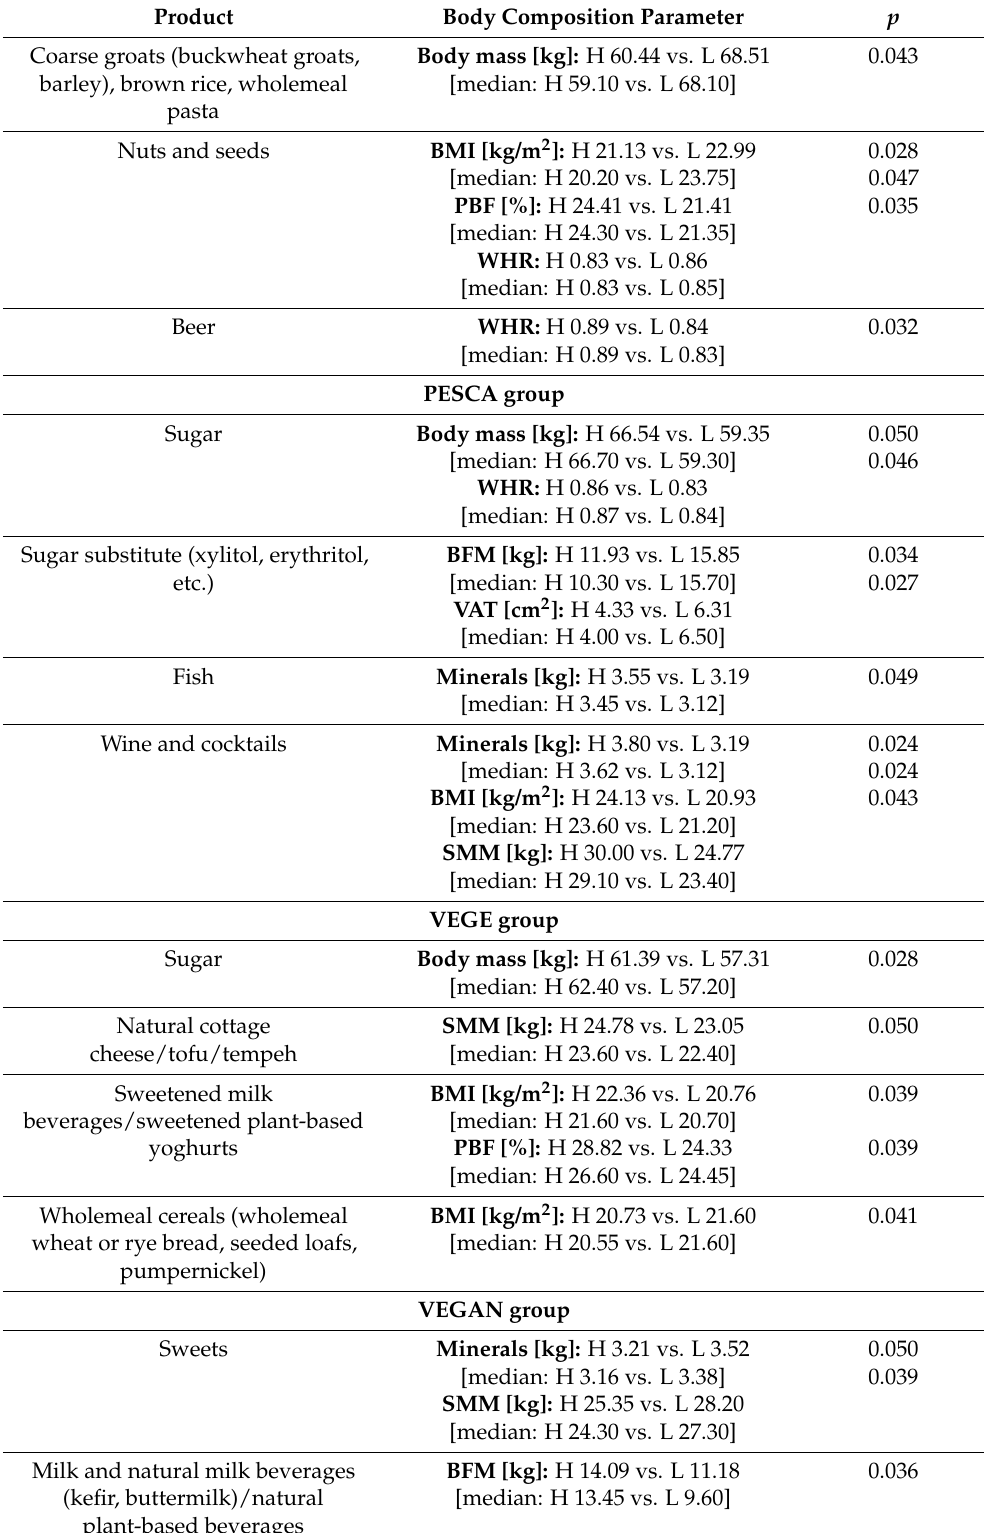
Table 9. Cont. Product Body Composition